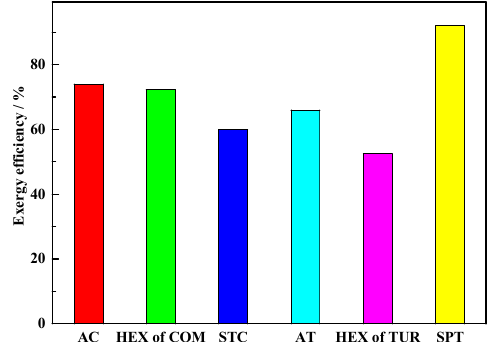
Figure 3. Exergy efficiencies of each subsystem.